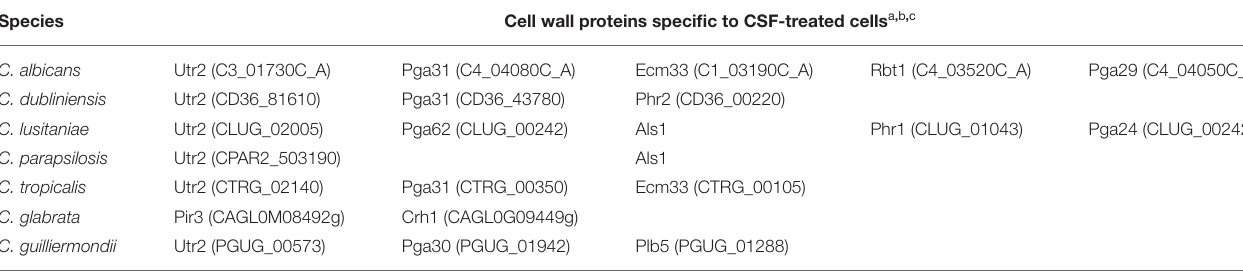
TABLE 3 | Caspofungin treatment specific proteins in different Candida species in RPMI-1640 medium. Species Cell wall proteins specific to CSF-treated cells a , b ,